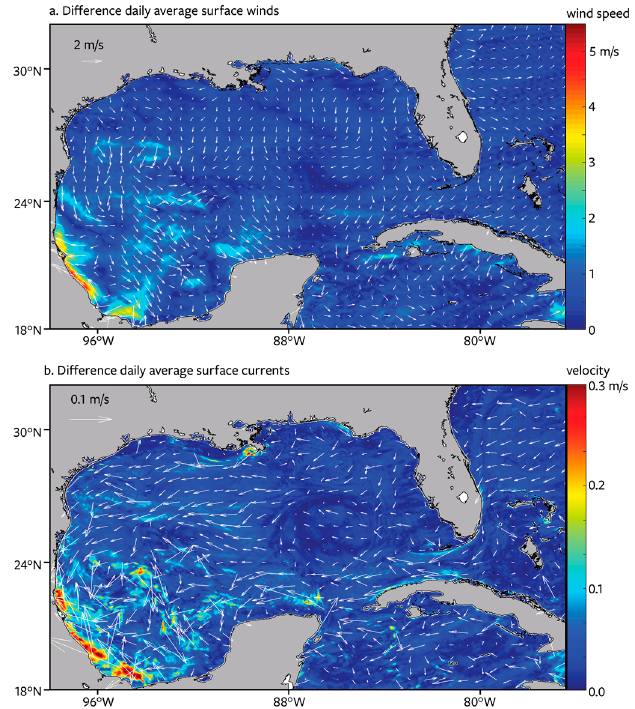
Figure 6. Differences in daily average surface winds (speed and direction) (upper panel) and daily average surface currents (bottom panel) after four days between Coupled Ocean Atmosphere–Wave– Sediment–Transport (COAWST) with Grenier–Bretherton (GB) atmospheric boundary-layer parameterization and the same model with improved Mellor–Yamada (MYNN) parameterization.